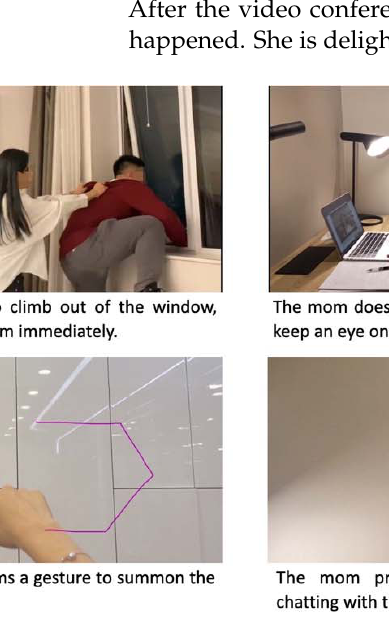
Figure 4. The scenario of the usage of the Go-Light.